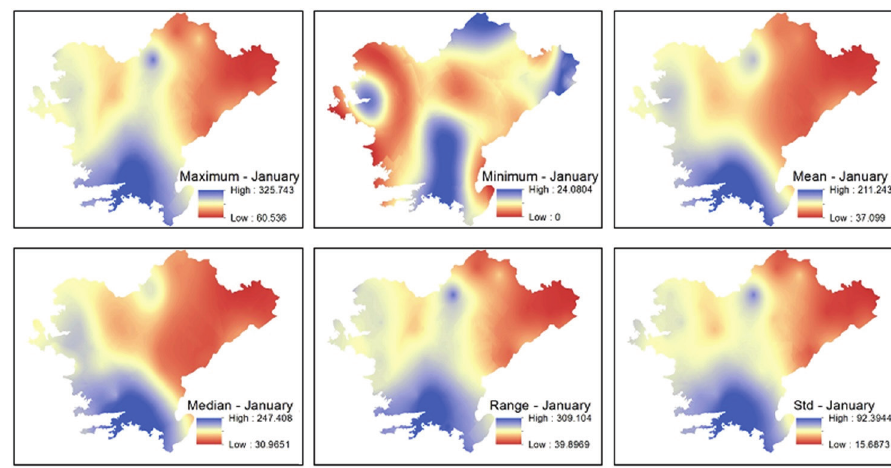
Figure 6 - Cell statistics of the precipitation for the month of January.